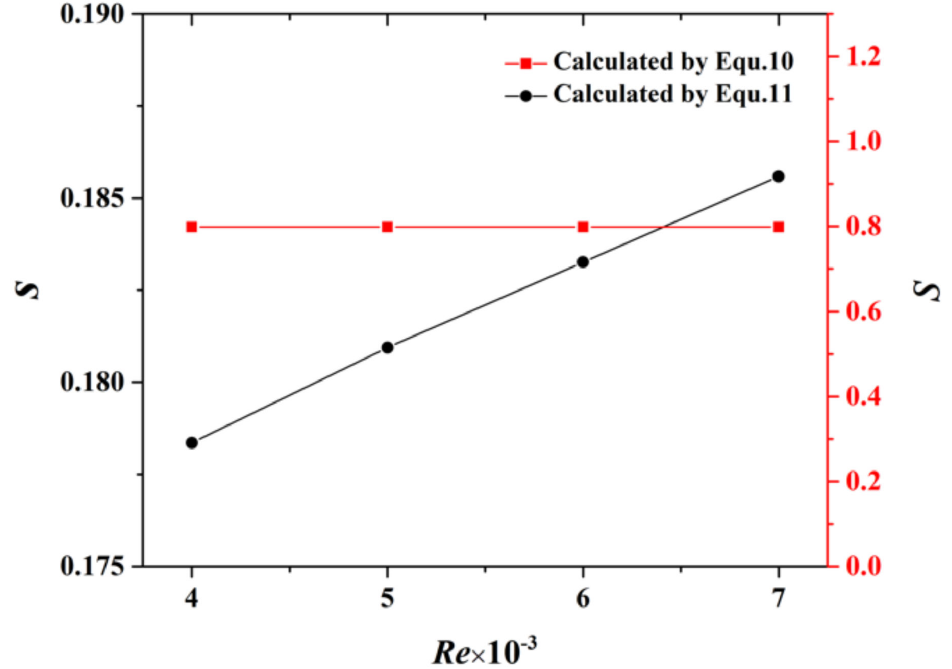
Figure 5. S of 45 ◦ swirl angle with different Re